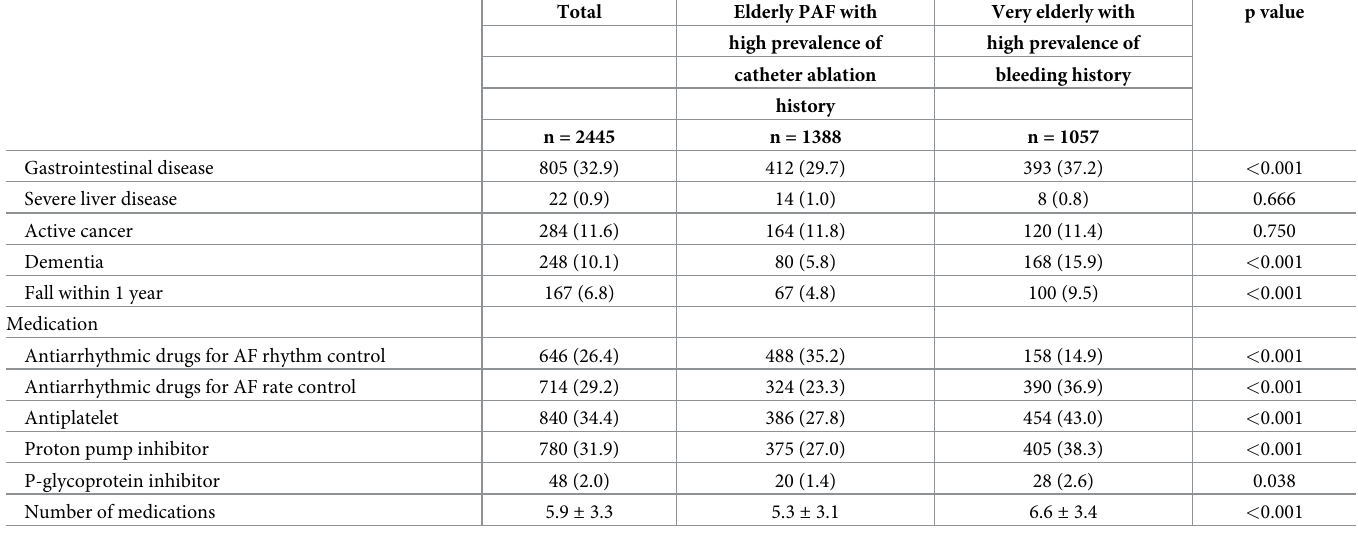
7.9% had undergone catheter ablation at baseline. Regarding thromboembolic risk, mean risk scores (3.2 for CHADS , 4.9 for CHA DS -VASc, and 3.8 for HELT-E S score) were higher in 2 2 2 2 2 cluster 2 compared with cluster 1. The prevalence of comorbidities was higher than in cluster 1 and included heart failure (48.6%), myocardial infarction (10.4%), cerebrovascular disease (29.8%), diabetes mellitus (35.9%), and history of major bleeding (10.8%). Antiplatelets were prescribed for 43.0% of these patients, and the average number of medications prescribed